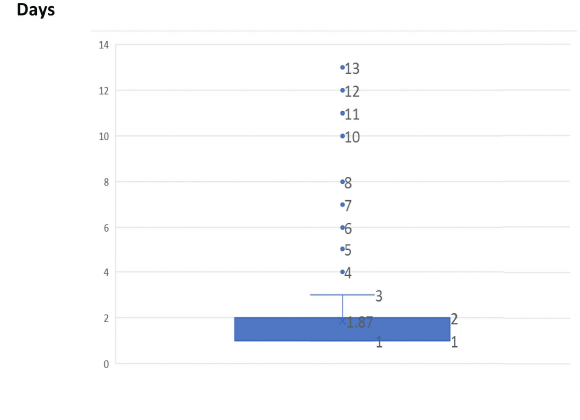
Figure 1 - Hospitalization Time.